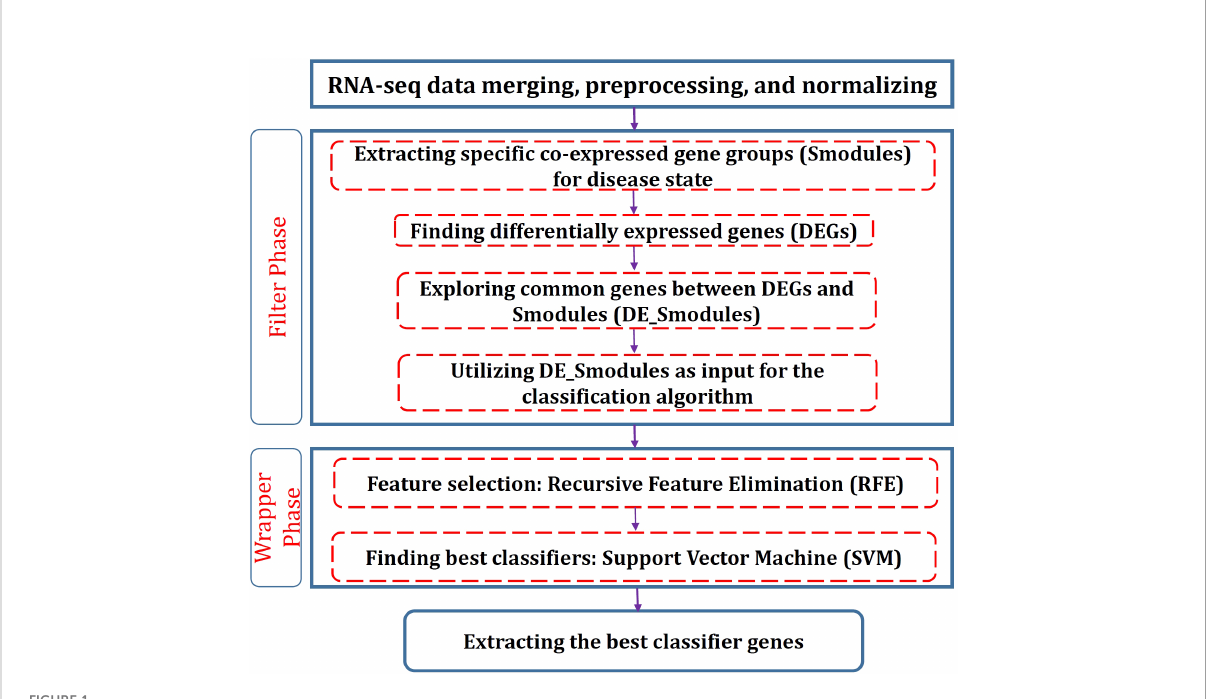
FIGURE 1 Flowchart of the proposed procedure in this